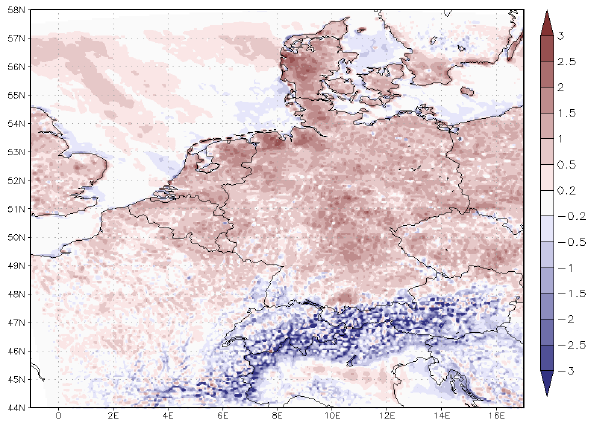
Figure 5. Di ff erence of v_10m for COSMO-eu minus COSMO- de (nudging runs), averaged about the storm event (96h) of “Tilo”